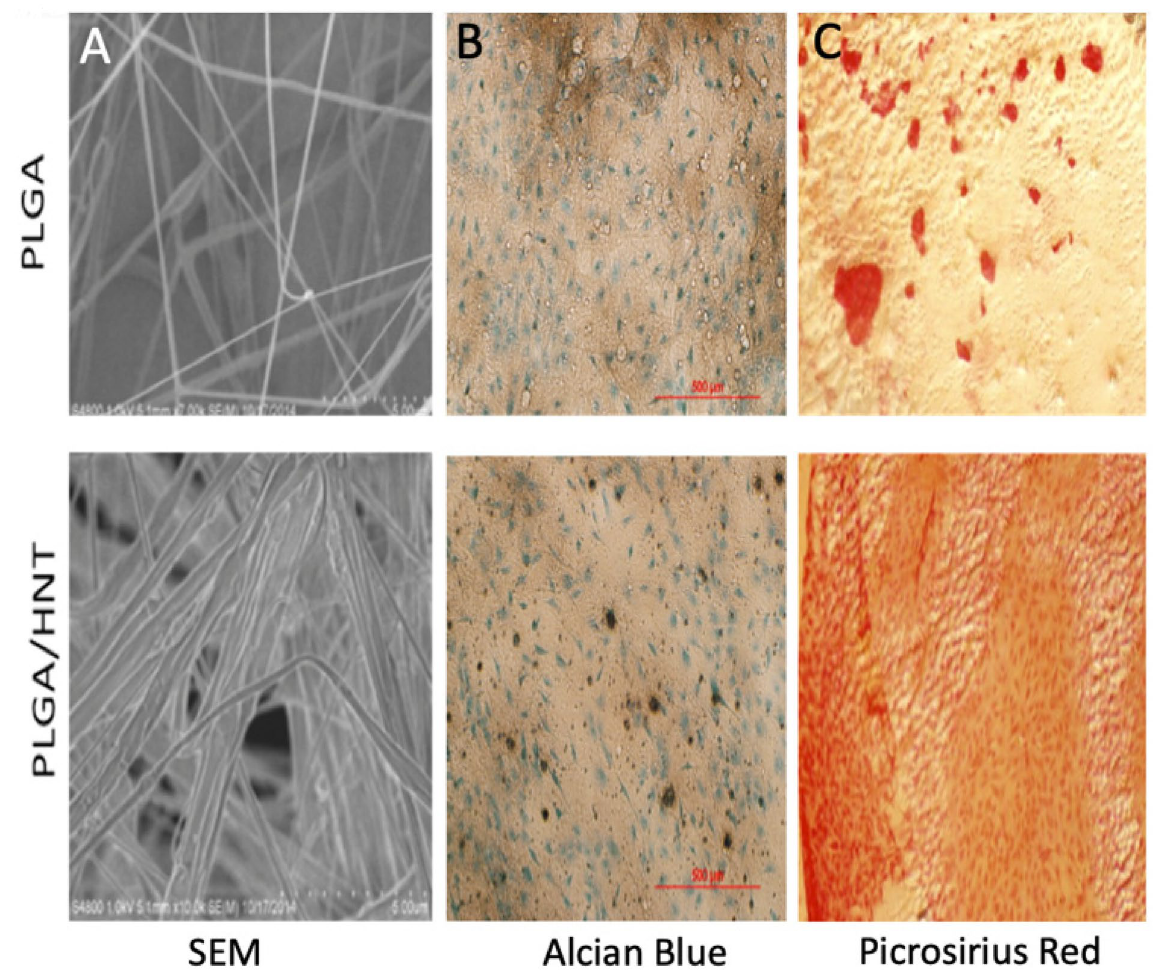
Figure 6. ( A ) SEM micrographs of blow-spun fibers with and without PLGA. Pre-osteoblasts were cultured on blow-spun fibers for 21 days. ( B ) Blow-spun fibers (+/ − HNTs) stained with Alcian blue on day 3. ( C ) Blow-spun fibers (+/ − HNTs) stained with Picrosirius red on day 3.